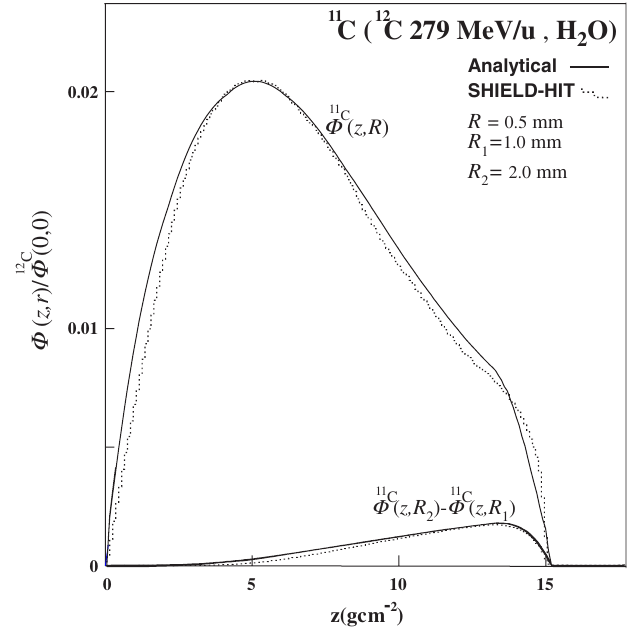
FIG. 5. The depth variation of the analytical narrow depth fluence, (cid:3) ð z; R Þ , (cid:3) ð z; R 1 Þ , and (cid:3) ð z; R 2 Þ of the secondary 11 C (cid:8) þ emitter in narrow 279 MeV = u 12 C beam in water described by analytical calculation of the fluence [Eq. (41)] (solid curves). The dotted histograms are SHIELD-HIT Monte Carlo results for comparison. The shape of the 11 C fragments in the narrow 12 C beam is strongly influenced by a wider spatial spread of the primary particles, and the wider scattering process of the gen- erated fragments, as the primary particle and the fragment energy decreases. Depending on the charge to mass ratio, the range of 11 C is slightly shorter relative the primary ion in contrast to the generated 11 B ions, as previously discussed [16], cf. Figs. 6 and